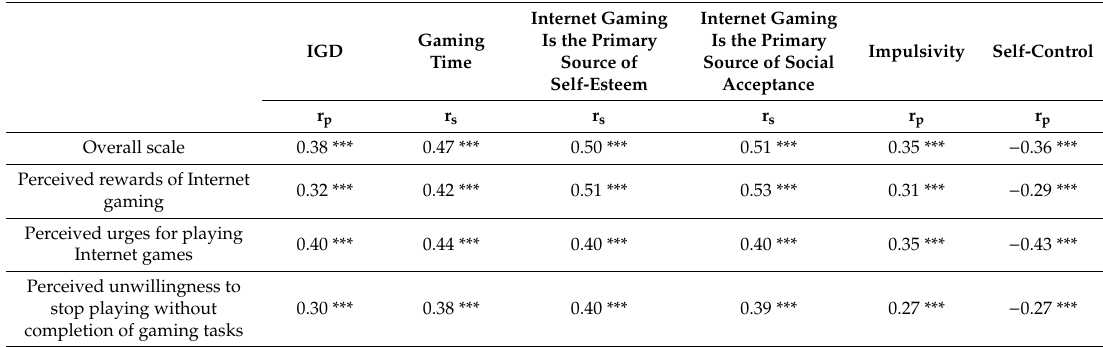
Table 6. Correlations between Internet gaming cognitions and external